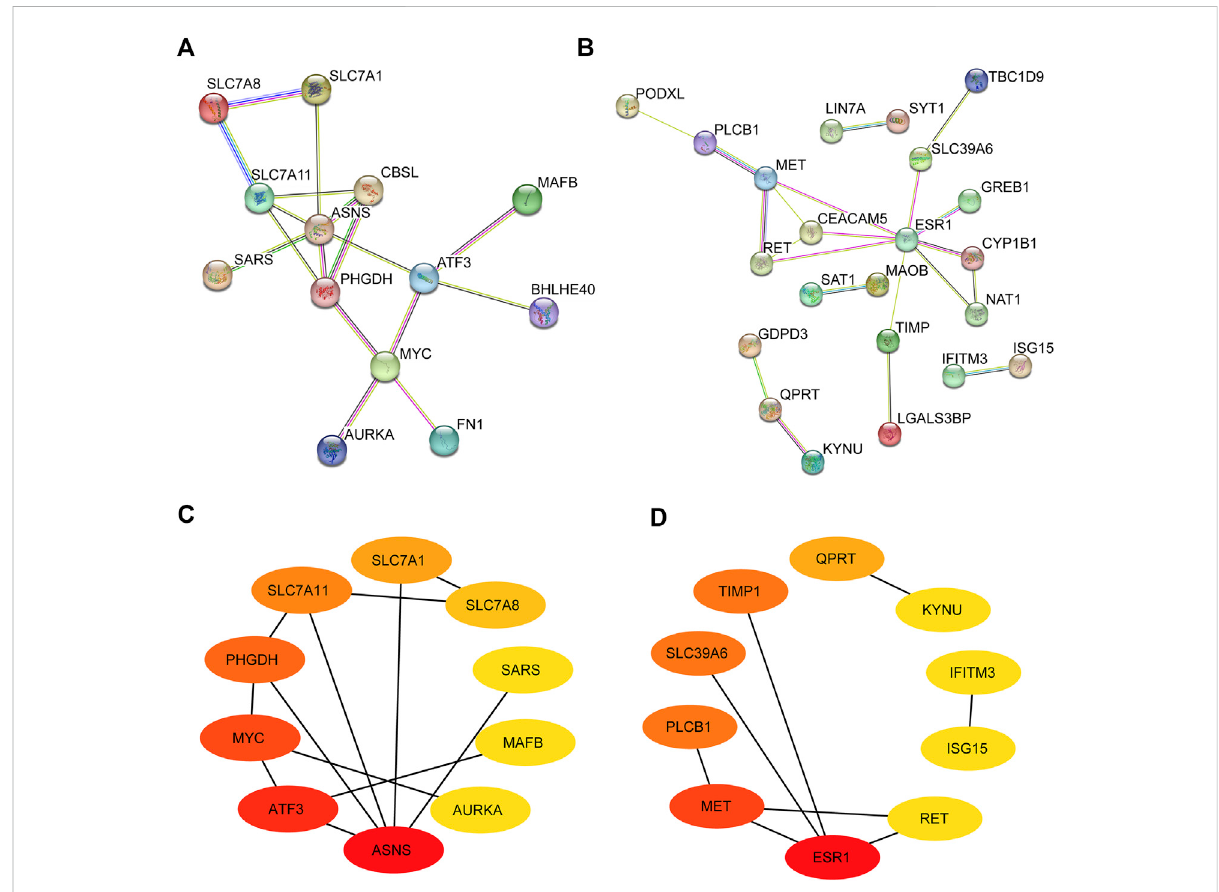
FIGURE 4 Identi fi cation of hub genes in PPI network. (A , B) PPI network of upregulated and downregulated DEmRNAs. (C , D) Top 10 upregulated and downregulated hub genes in the PPI network. Darker colors represent higher scores in the